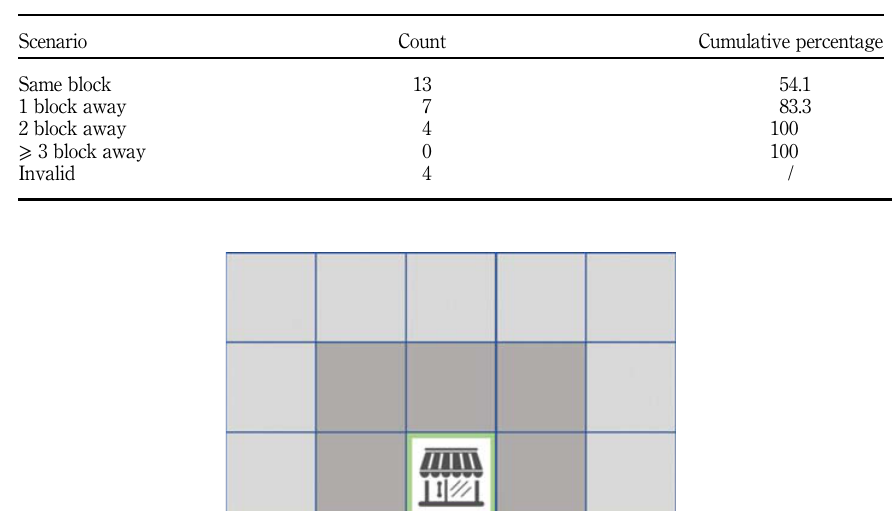
Figure 5. Distance in terms of